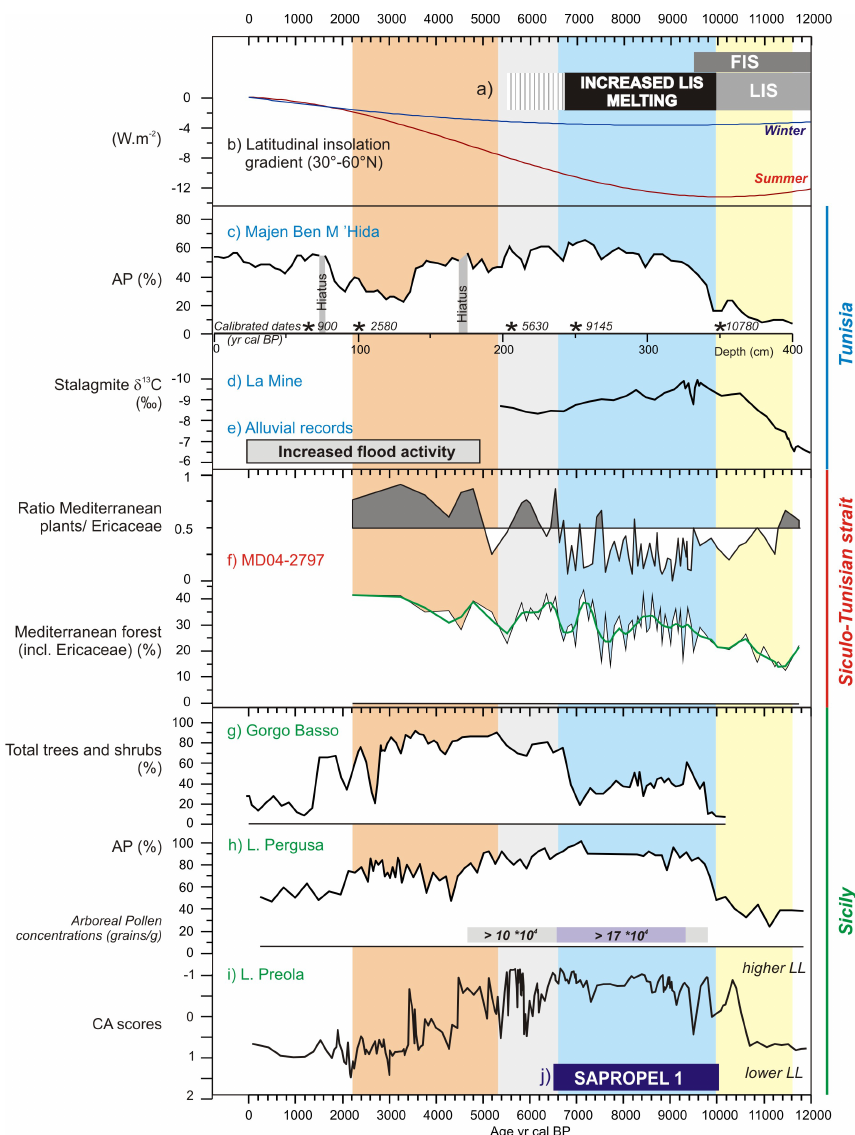
Fig. 6. Comparison of the pollen data from core MD04-2797CQ with other records from southern Central Mediterranean and with insolation and ice sheet forcings. Forcings – (a) Early Holocene ice sheet deglaciation: disappearance of the Fennoscandian Ice Sheet (FIS) at 9.5kyr cal BP (Lundqvist and Saarnisto, 1995) and enhanced Laurentide Ice Sheet (LIS) retreat between 10 and 6.8kyr cal BP with only small ice caps remaining up to 5.5ka (Carlson et al., 2008); (b) Summer (JJA) and winter (DJF) latitudinal insolation gradient calculated from insolation values at 60 ◦ and 30 ◦ N (Berger and Loutre, 1991); Tunisia – (c) Majen Ben M’Hida peat pollen sequence: digitalized data versus depth (Stambouli-Essassi et al., 2007), asterisks: original dated levels (65cm: 985 ± 30yr BP; 100cm: 2500 ± 50 yr BP; 205cm: 4894 ± 40yr BP; 250cm: 8190 ± 50yr BP; 350cm: 9480 ± 100yr BP) and calibrated ages using Calib 6.11 (903 (873–959); 2578 (2365– 2740); 5629 (5585–5716); 9144 (9014–9287); 10782 (10504–11143) yr cal BP); (d) δ 13 C speleothem record from the La Mine Cave (Genty et al., 2006); (e) Shaded bar representing the increased fluvial dynamics since 5ka with recurrent floods associated to drier conditions, based on alluvial sequences from arid to semi-arid Central and North Tunisian floodplains (Zielhofer and Faust, 2008); Siculo-Tunisia Strait – (f) MD04-2797CQ pollen data: total tree and shrub percentages including Ericaceae with smoothing cubic spline (bold green line) and ratio of Mediterranean plants to Ericaceae; Sicily – (g) Total trees and shrubs percentages from Gorgo Basso pollen sequence (Tinner et al., 2009); (h) Arboreal pollen percentages and concentrations from Lake Pergusa sequence (Sadori and Narcisi, 2001; Sadori et al., 2011); (i) Relative changes in lake level (LL) from Lake Preola (Magny et al., 2011b); (j) Interval corresponding to Sapropel 1 after Mercone et al. (2000). The colored vertical bars represent the successive intervals as described in the text: yellow for the dry interval at the beginning of the early Holocene, blue for the wet early Holocene phase, grey for the mid-Holocene transitional interval and orange for the mid- to late Holocene phase of increasing